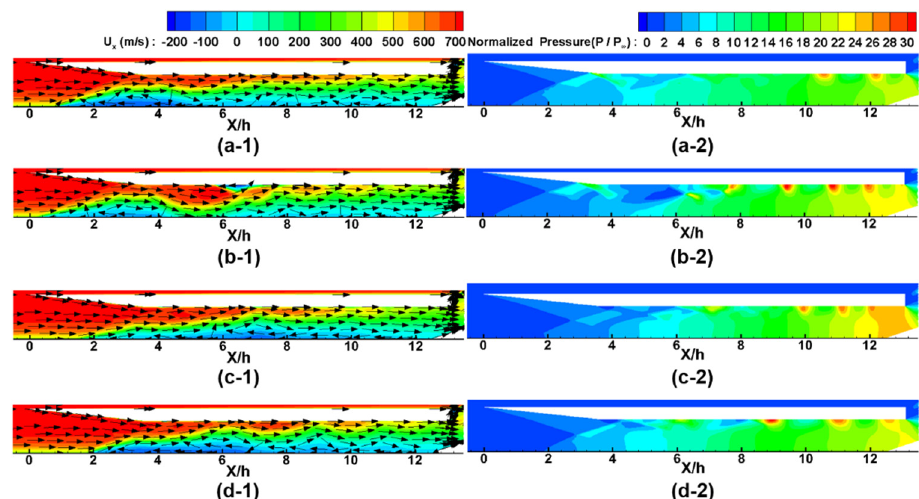
Figure 7. Axial velocity contours with velocity vectors ( left ) and normalized pressure contours ( right ) for Pattern 2: ( a-1 ) axial velocity at point [ a (cid:2870) ]; ( a-2 ) normalized pressure at point [ a (cid:2870) ]; ( b-1 ) axial velocity at point [ b (cid:2870) ]; ( b-2 ) normalized pressure at point [ b (cid:2870) ]; ( c-1 ) axial velocity at point [ c (cid:2870) ]; ( c-2 ) normalized pressure at point [ c (cid:2870) ]; ( d-1 ) axial velocity at point [ d (cid:2870) ]; ( d-2 ) normalized pressure at point [ d (cid:2870) ].